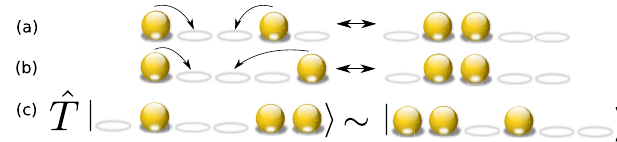
FIG. 3. Scattering schemes and symmetries in a Landau level. Preservation of COM allows a cluster of particles to scatter according to line (a), but forbids the scattering according to line (b). (c) The many-particle translation operator configuration by moving every particle q orbitals to the right (in this example, q ¼ 2 ). Many-body states at filling ν ¼ p=q are invariant under this symmetry, which gives rise to the topological degeneracy equal to q